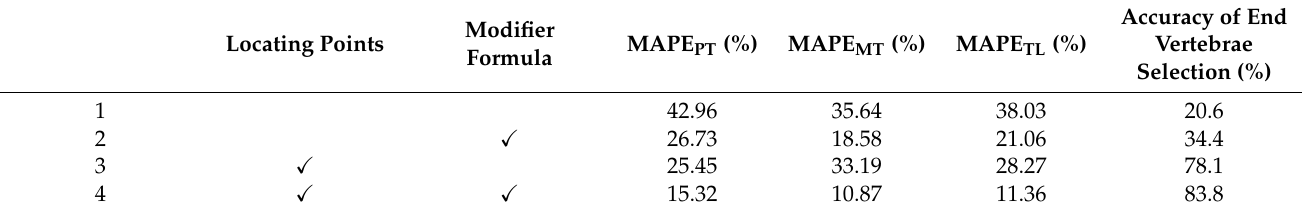
Table 2. Impact of positioning points and correction formula on Detection Results.